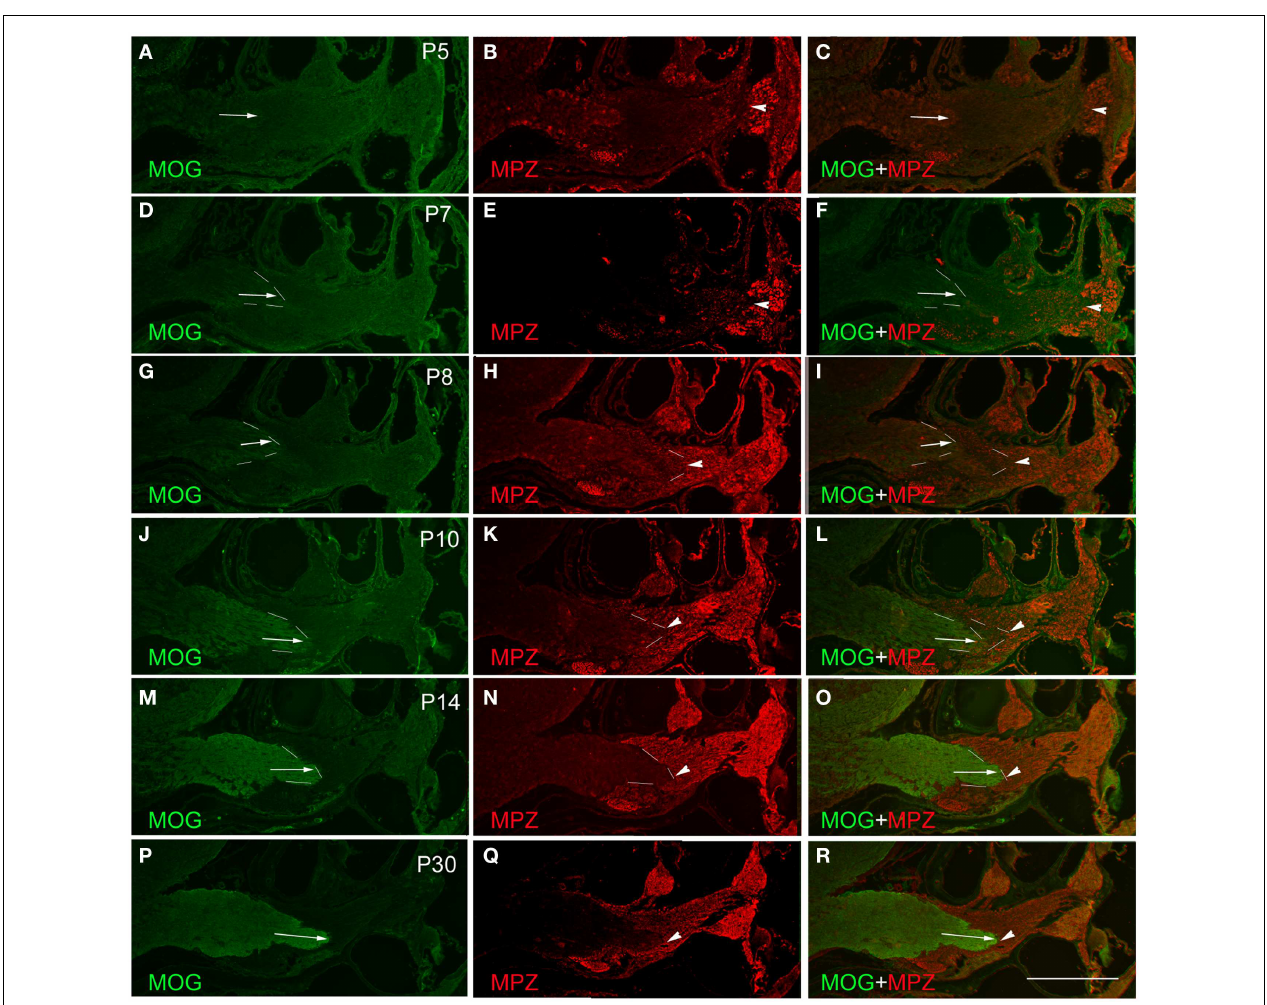
on P5 (B) , strengthened from P7 to P10 [arrowheads in (E) , (H) , and (K) ; dotted lines indicate the boundary], and held stable after P14 [arrowheads in (N) and (Q) ; dotted lines indicate the boundary]. MPZ expression was initially observed along the cochlear nerve in close proximity to the apical turn of the cochlea as early as P5 [arrowhead in (B) ]. Its expression extended centrally toward PCTZ from P7 to P10 [arrowheads in (E) , (F) , (H) , (I) , (K) , and (L) ], and reached the PCTZ after P14 [arrowheads in (N) , (O) , (Q) , and (R) ]. Scale: 50 µ m shown in (R)